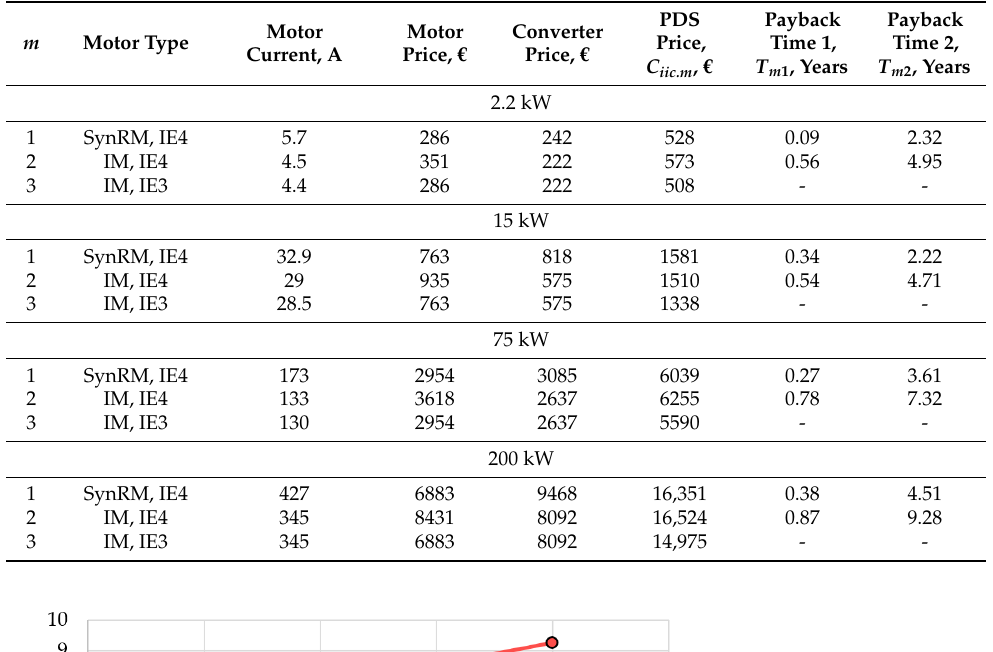
Table 9. Motor payback period.